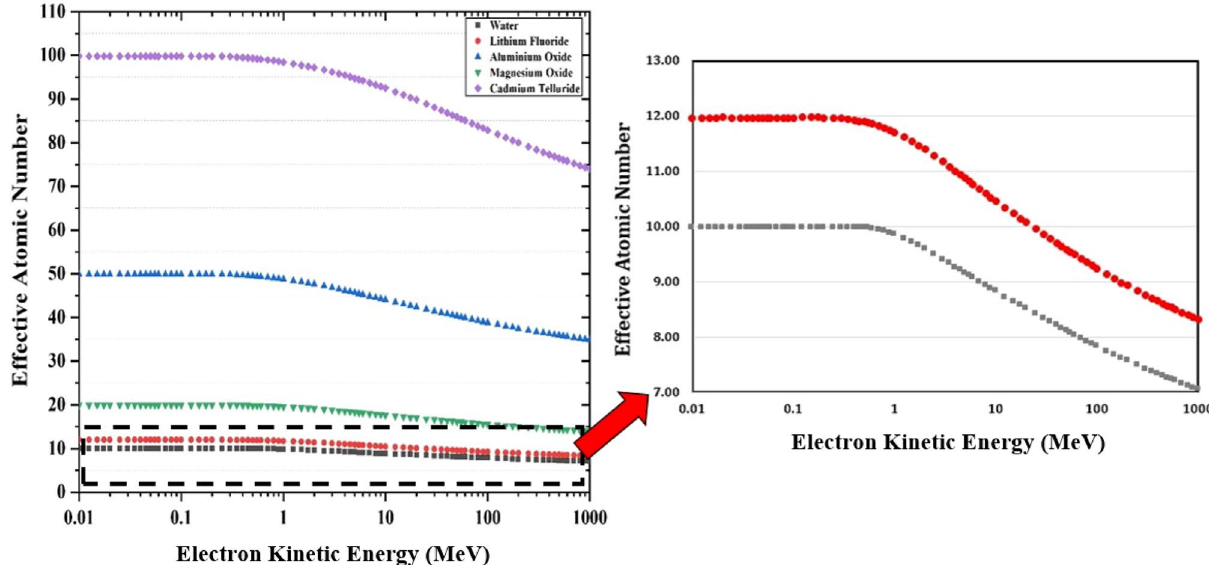
Figure 1. Variation of Z eff with kinetic energy of Electron for water, lithium fluoride, aluminum oxide, magnesium oxide and, cadmium telluride. At low energies the effective atomic number is close to the number of electrons in molecular unit of